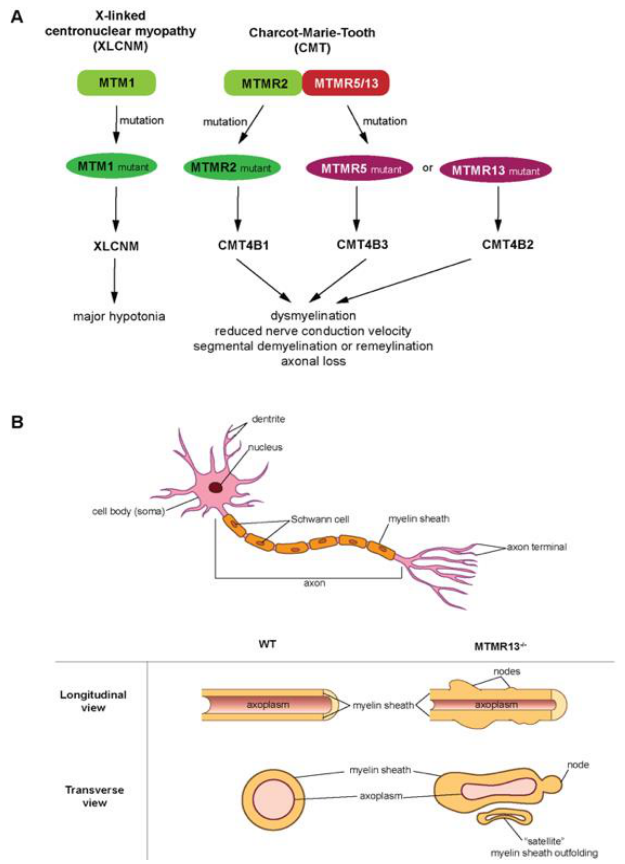
Figure 2. Myotubularins (MTMs) in diseases: ( A ) X-linked centronuclear myopathy (XLCNM) and Charcot-Marie-Tooth (CMT), pathologies associated with MTM family mutations. XLCNM is a rare congenital myopathy characterized by decreased muscle tone or weakness (hypotonia), and is caused by mutations to the MTM1 gene. CMT denotes a group of peripheral nerve neuropathies with an incidence of ~1 in 2500 people, and is characterized by abnormal myelin folding, diminished nerve conduction velocities, as well as peripheral axon loss. CMT type 4B (CMT4B) is caused by mutations in the MTM family proteins (MTMR2, MTMR5 or MTMR13) which lead to CMT4B1, CMT4B3 or CMT4B2, respectively. ( B ) (Top) Canonical representation of a PNS neuron and its various processes. (Bottom) Idealized illustration adopted from Robinson et al. [30] of the aberrant myelin phenotypes associated with CMT4B2 (longitudinal and transverse views of MTMR13-/- knockout axons) as compared to Wild Type (WT) axons. Abnormal myelination, as depicted by “satellite” myelin outfoldings, as well as myelin “nodes”, are present in mouse models deficient of MTMR13, resulting in diminished nerve conduction velocities typical of CMT4B